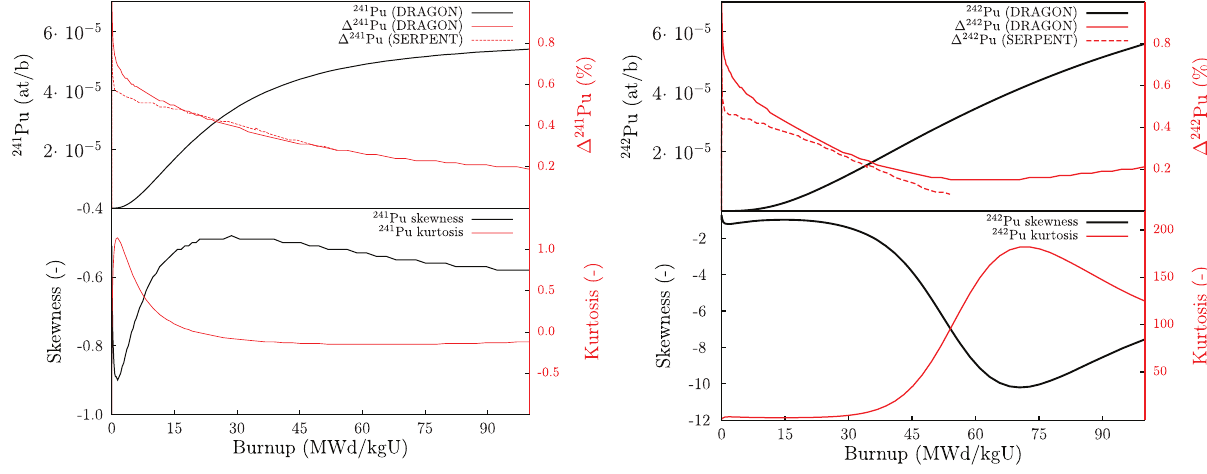
Fig. 3. Calculated concentrations for 235 U and 239 Pu with their uncertainties (DRAGON and SERPENT), skewness and kurtosis as a function of the pincell burnup value (DRAGON only).